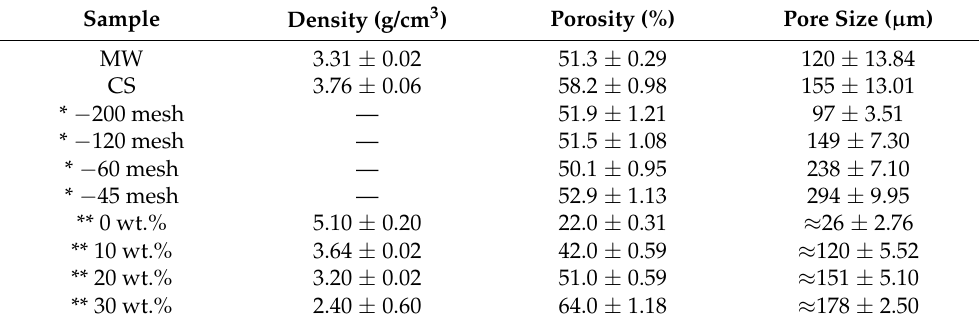
Table 1. Density, porosity, and pore size values of the porous NiTi alloys prepared by MW and CS, and from the literature results. Sample Density (g/cm 3 ) Porosity (%) Pore Size ( µ m) MW 3.31 ± 0.02 51.3 ± 0.29 120 ± 13.84 CS 3.76 ± 0.06